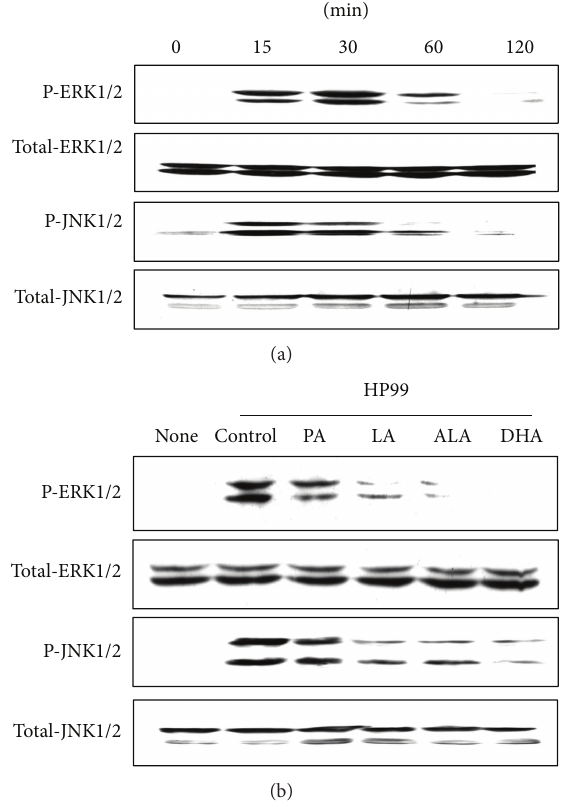
Figure 4: Effects of PUFAs on activation of ERK and JNK in H. pylori -infected AGS cells. (a) AGS cells were infected with H. pylori for the indicated time points (15, 30, 60, and 120min). Phosphospecific and total forms of ERK and JNK were measured by western blot analysis. (b) AGS cells were pretreated with individual fatty acid (100 𝜇 M) for 24 h and then cultured with H. pylori for 30 min.